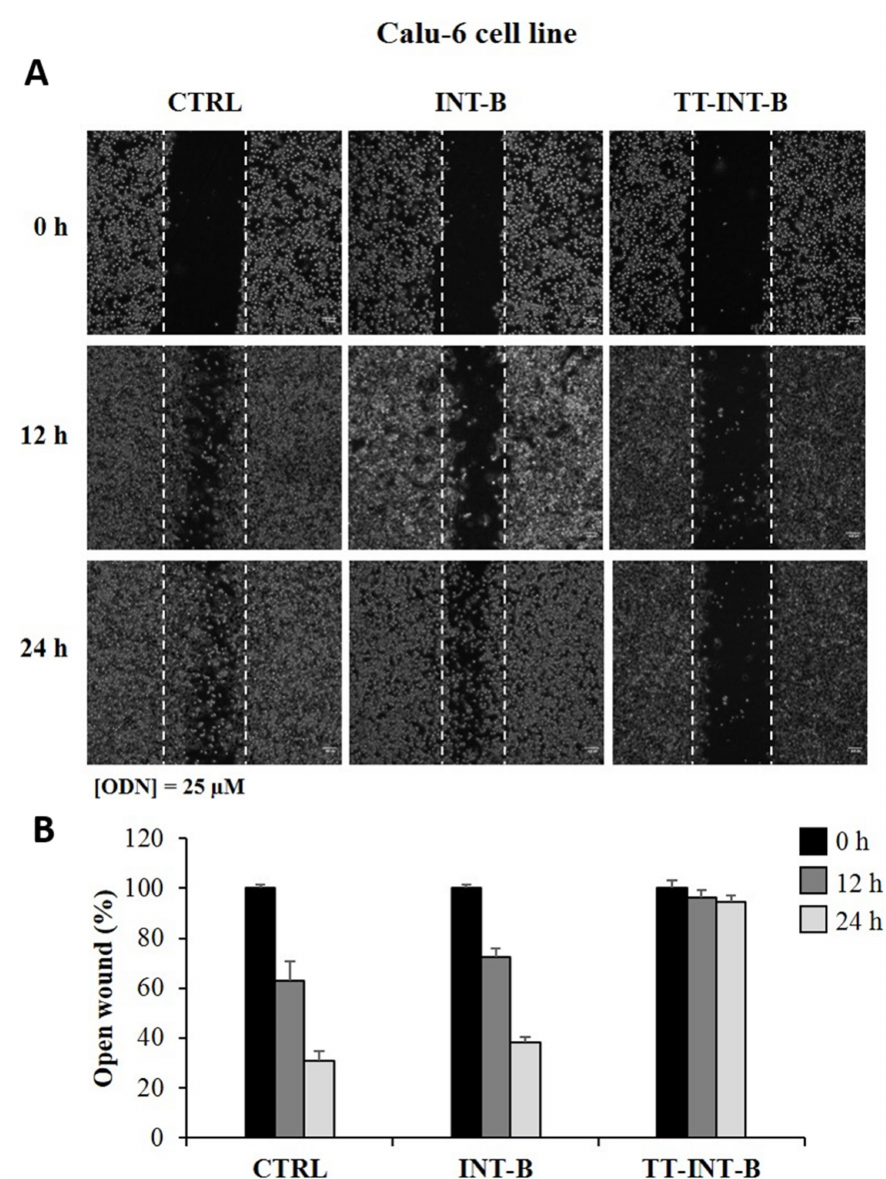
Figure 7. Effects of INT-B and TT-INT-B on cell migration. Representative images of the wound heal- ing assay in the Calu-6 cell line ( A ). The cells were treated with 25 µ M of INT-B and TT-INT-B for 24 h. Wound widths were measured at 0, 12, and 24 h on three fields per well and aver- aged. Data are expressed as the fold-decrease of area with respect to the control set as 100% ( B ). Bars represent the mean of triplicate experiments; error bars represent the standard